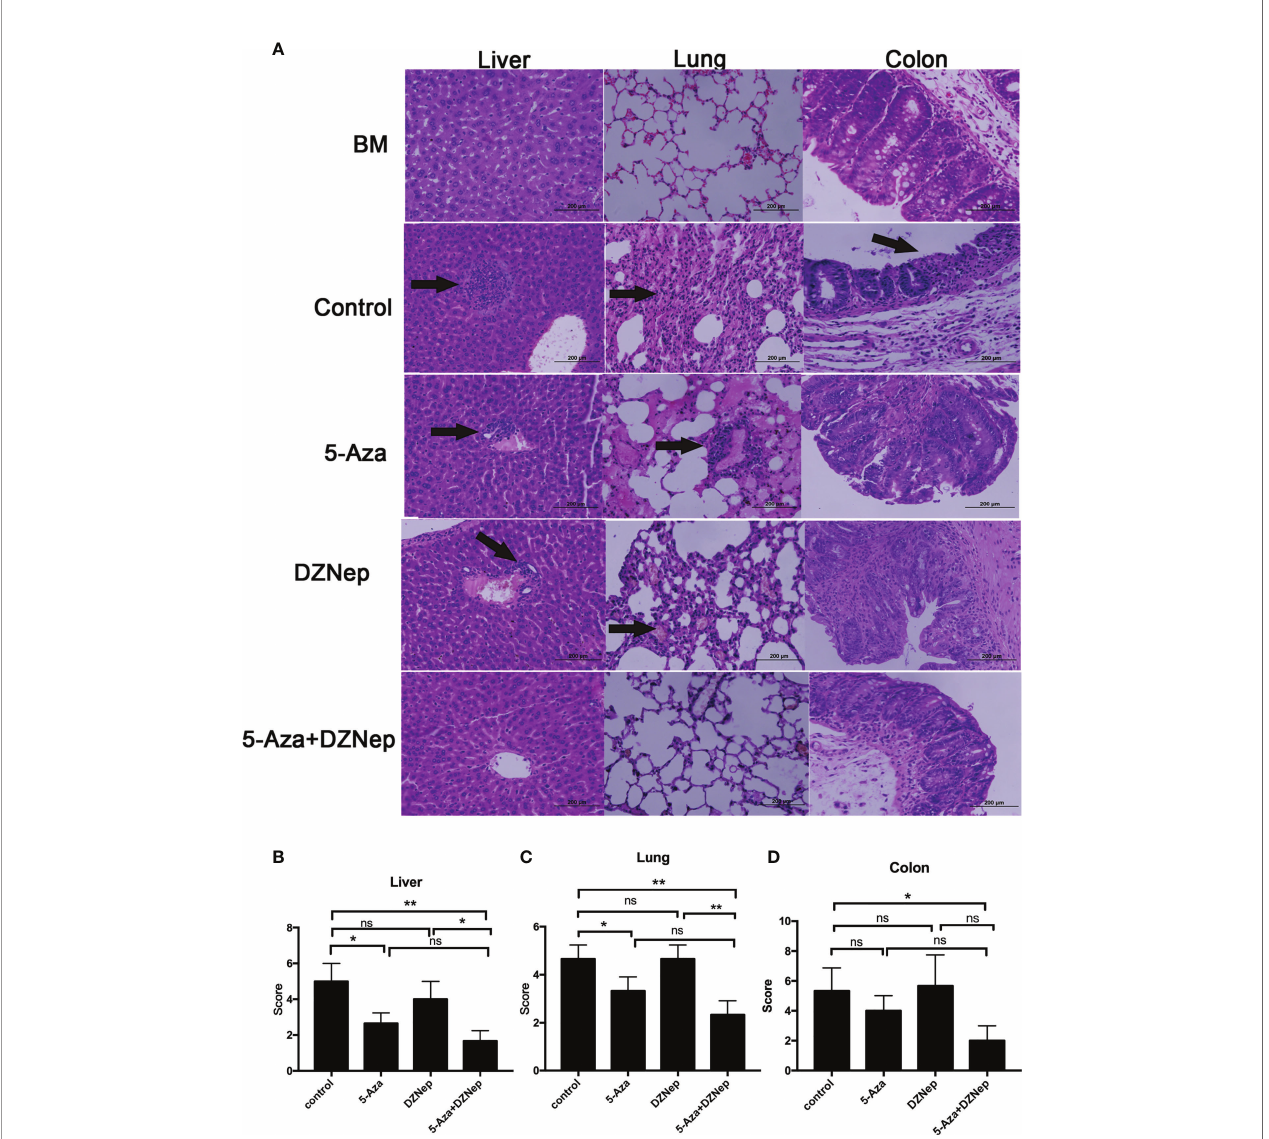
FIGURE 4 | Histopathology of acute graft- versus -host disease (aGvHD) target tissues after allogeneic hematopoietic stem cell transplantation (allo-HSCT). (A) Hematoxylin and eosin (H&E) staining of the liver, lung, and colon in the different treatment groups under a microscope. (B – D) Comparisons of the liver (B) , lung (C) and colon (D) pathology scores in the different treatment groups. Samples of livers, lungs, and colons were obtained at day 21 after transplantation and then stained with H&E. The severity of the pathological changes was scored using a grading scale under a microscope. The results were representative of three independent experiments. Each group contained 5 – 8 mice. *P < 0.05, **P < 0.01, ns: P >